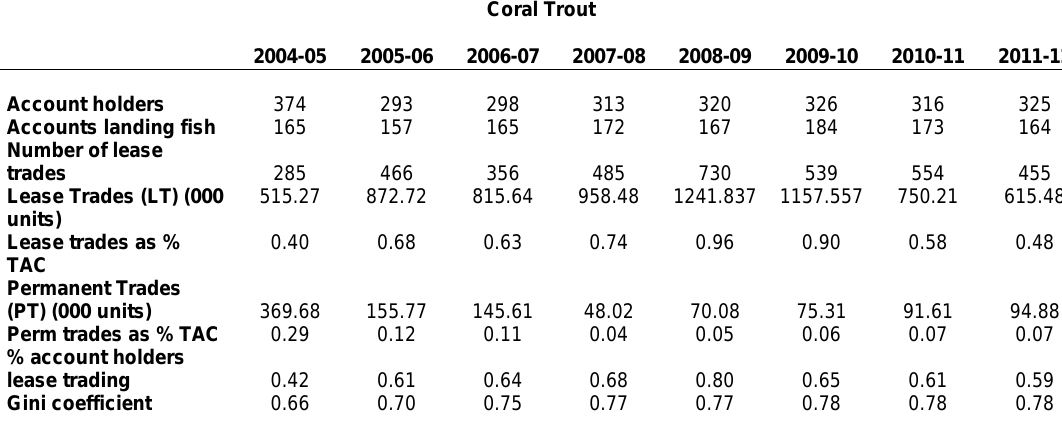
Table A1.1. Summary characteristics of the coral trout (CT) quota market.